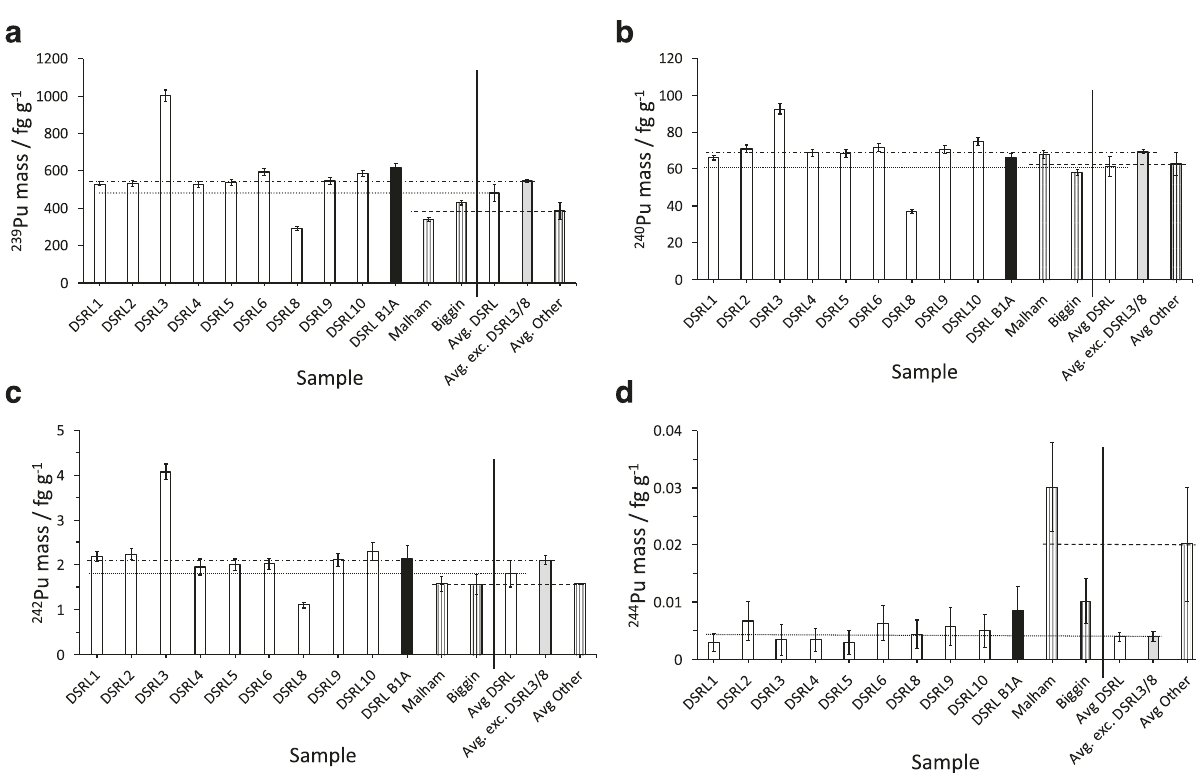
Fig. 2 Plutonium mass abundance (fg g − 1 ) as a function of sample identi fi er in soil. a 239 Pu, b 240 Pu, c 242 Pu and d 244 Pu. Uncertainties are depicted by ±1 σ error bars. Data for samples taken on-site at Dounreay and the corresponding weighted averages (where applicable to the right of the vertical solid line) are depicted as white bars, off-site nearby by black bars and off-site far away by bars with vertical stripes. The horizontal lines represent the weighted average for on-site at Dounreay (dotted), on-site excluding DSRL3 and DSRL8 (dotted-dashed) and off-site-far (dashed). The weighted average for the on- site data excluding samples DSRL3 and DSRL8 is denoted by the shaded grey bar. The corresponding data for weighted averages for on-site, on-site without DSRL3 and DSRL8, off-site nearby, Malham and Biggin are given in Table 1.